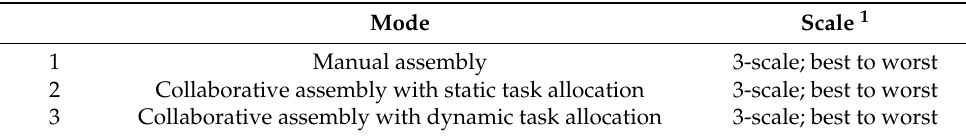
Table A5. Questionnaire on preferred task allocation